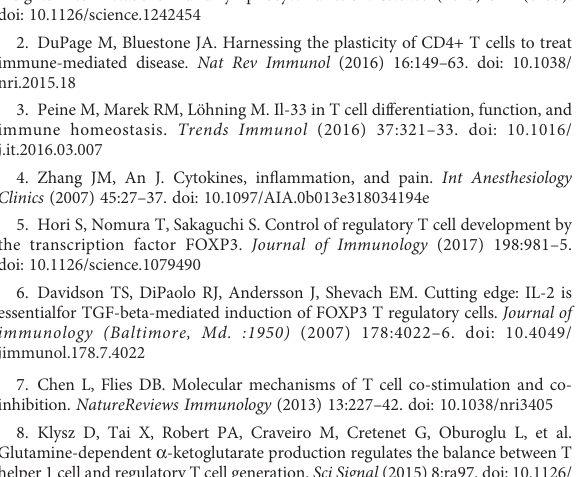
SUPPLEMENTARY FIGURE 2 (A) A microenvironment de fi ned by optimal levels of exogenous TGF- b , IL-10, IL-21cytokines, normoxic conditions, and depleted levels of tryptophan leads to a Treg phenotype and transientmanifestation of Th17. (B) Optimal levels of IL-10, IL-21 and tryptophan, but depleted TGF- b under hypoxiaconditions induce a Treg-Th17